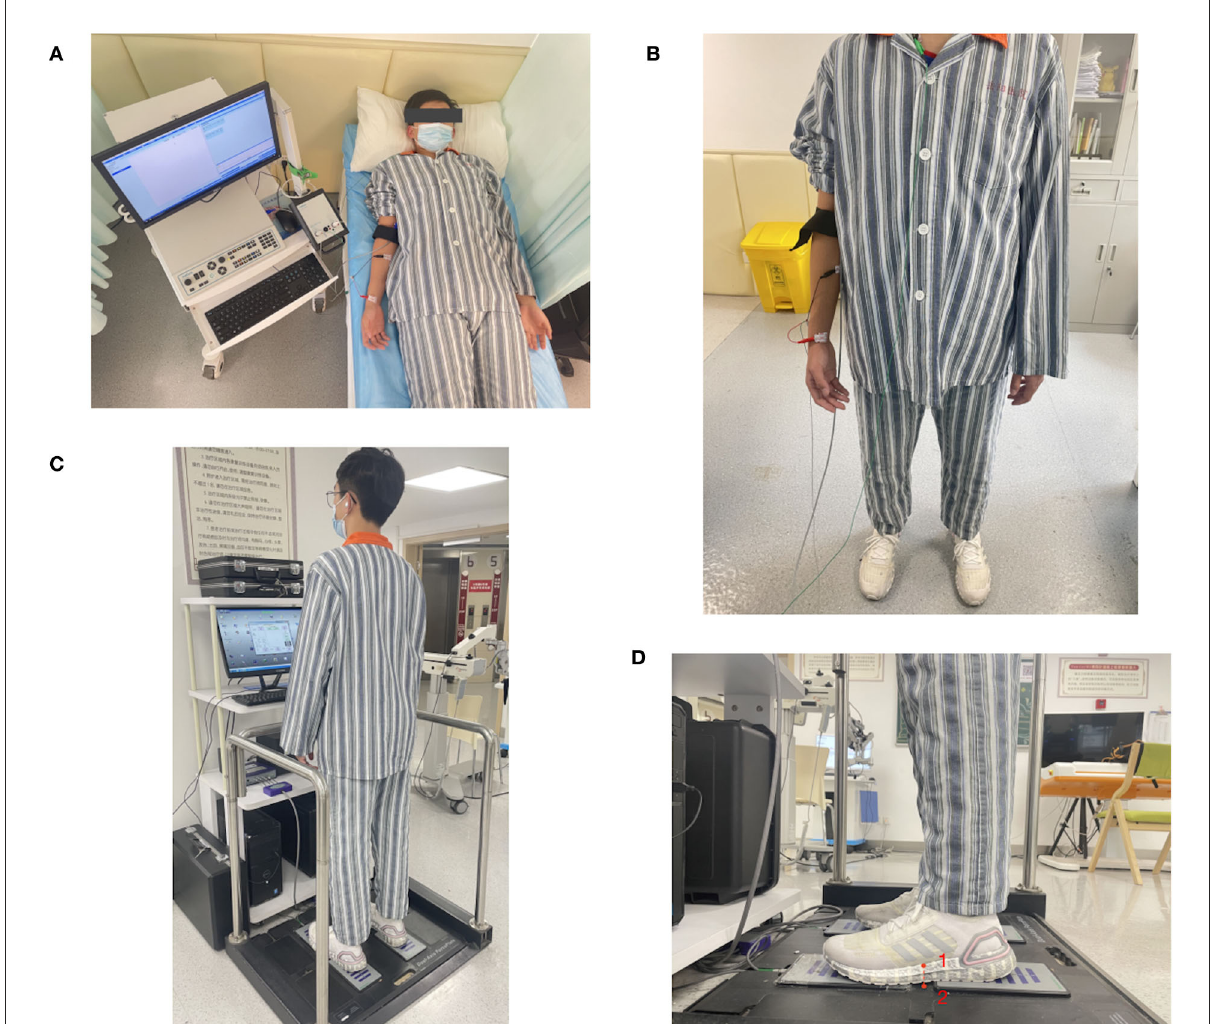
FIGURE1 Flexor carpi radialis (FCR) H-reflex examination in the (A) supine and (B) static standing positions; (C) When evaluating postural stability in static standing without support over 5s, participants were instructed to stand on the force plates with their feet hip-width apart, head and trunk centered and neutral, and bilateral UEs naturally hanging; (D) Each foot of the patient was across the gap of 2 the force plates on one side, and the midpoint of the medial foot arch (red point 1) was just above the midpoint of the gap (red point 2) when the patient stood on the force